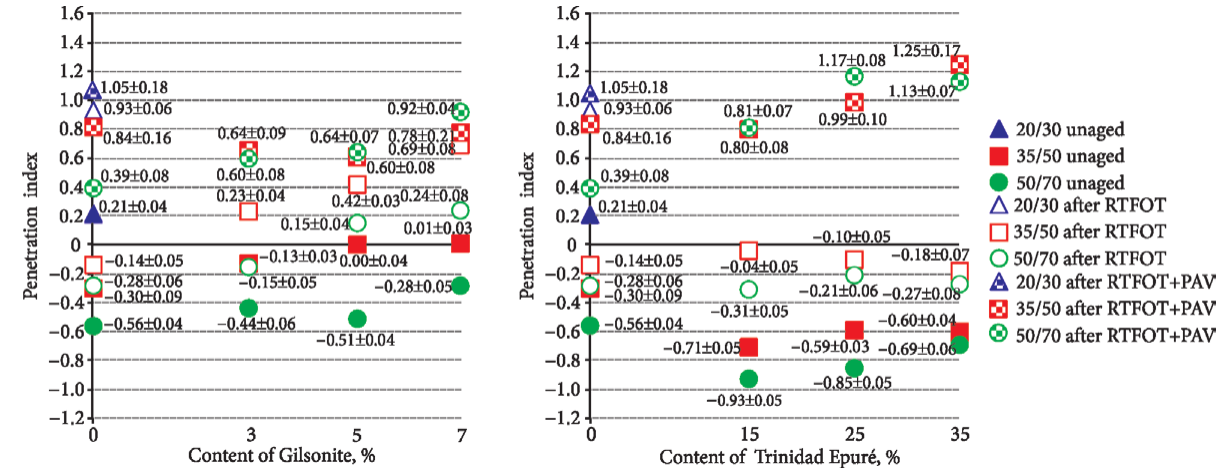
Fig. 3. The values of the Penetration Index for the Gilsonite and Trinidad Epuré modified asphalt binders